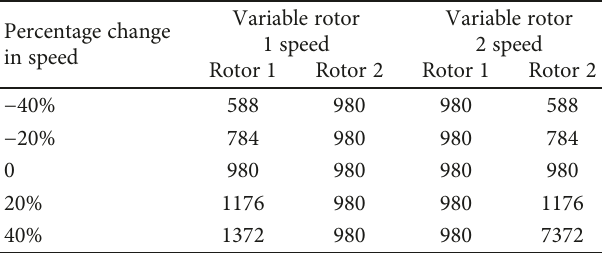
Figure 8: The static pressure contour of CRF under design Table 2: The scheme of variable rotating speed matching.